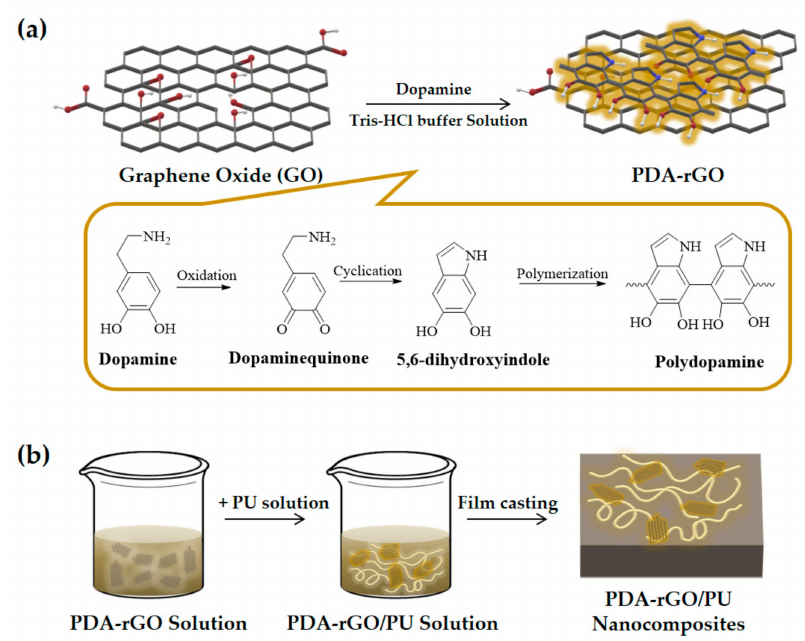
Figure 2. Schematic illustration of ( a ) the preparation of PDA–rGO, and ( b ) PDA–rGO/polyurethane (PU)